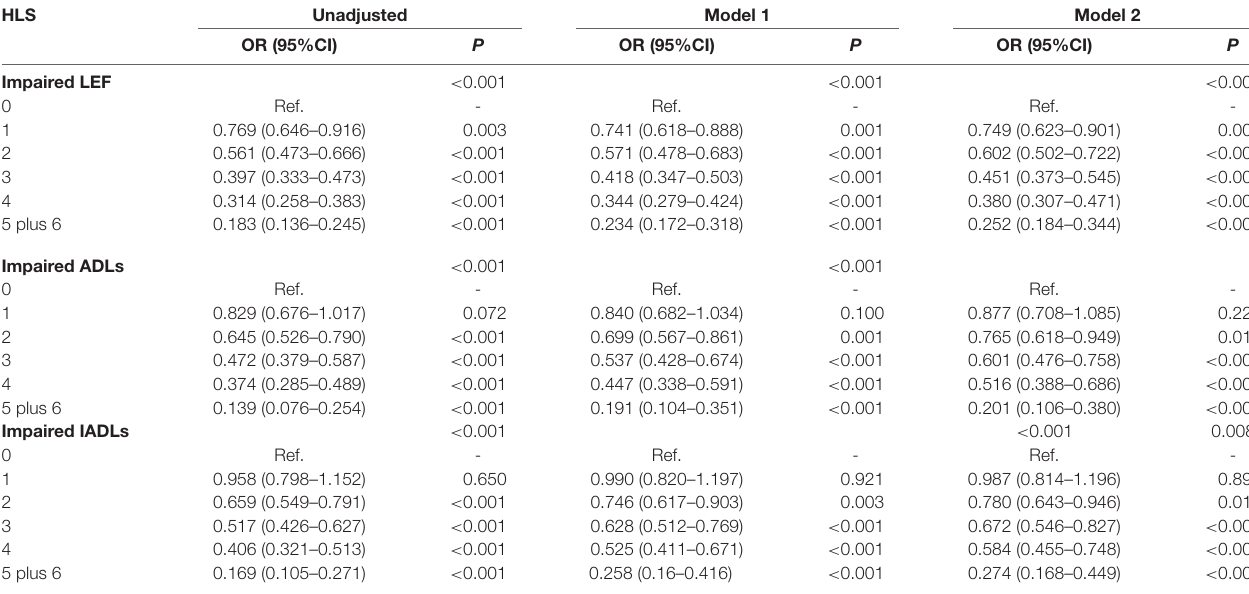
TABLE 2 | Adjusted odds ratios (OR) for the association of healthy lifestyle score with impaired lower-extremity function (LEF), activities of daily living (ADLs), and instrumental ADLs (IADLs). HLS Unadjusted Model 1 Model